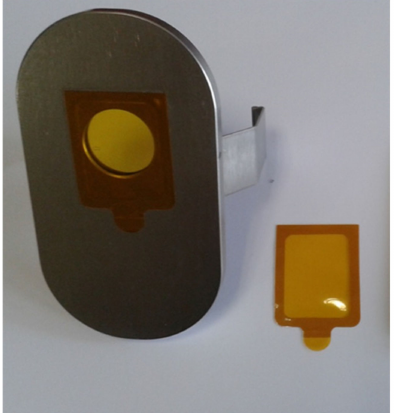
Figure 5. Protective shield of a Niton XL3t spectrometer.